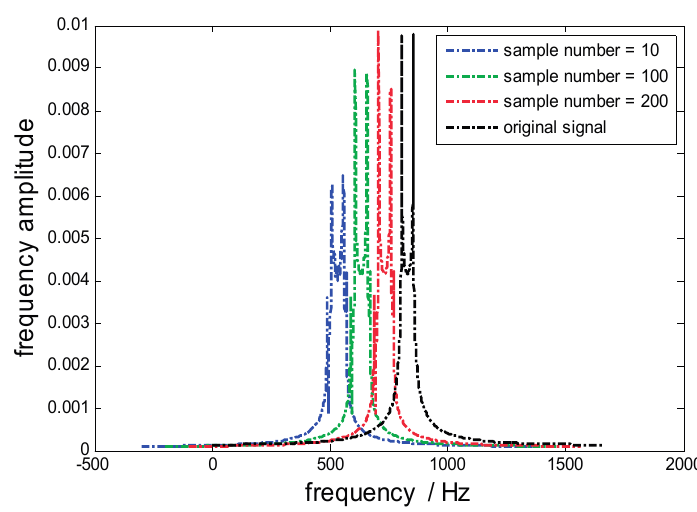
Figure 13. Frequency spectra of reconstructed signals with various numbers of samples.